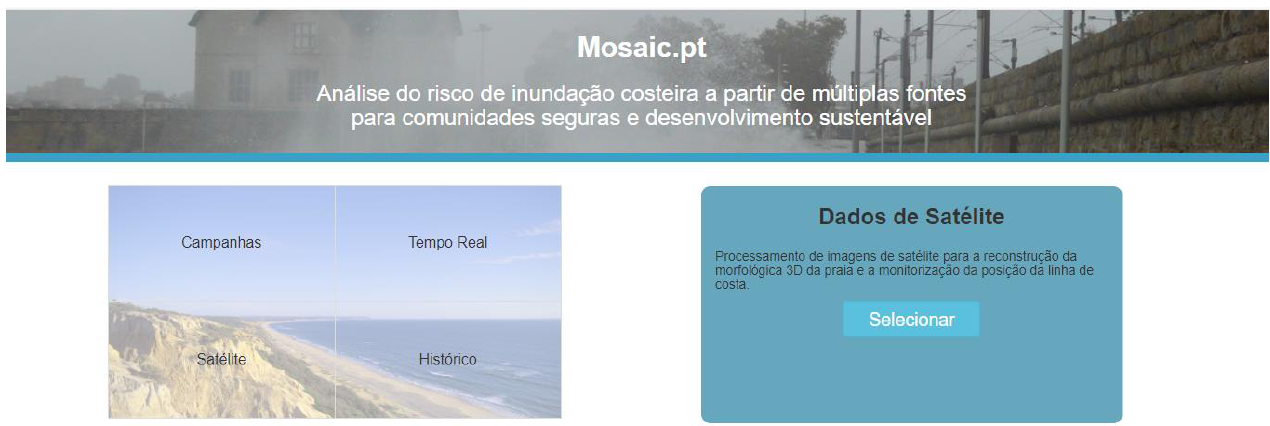
Figure 10. View of the data ( dados ) page. In this example, satellite data ( dados de satélite ) was pre-selected on the left (image-based) table. The actual data are accessed by clicking on the box on the right.